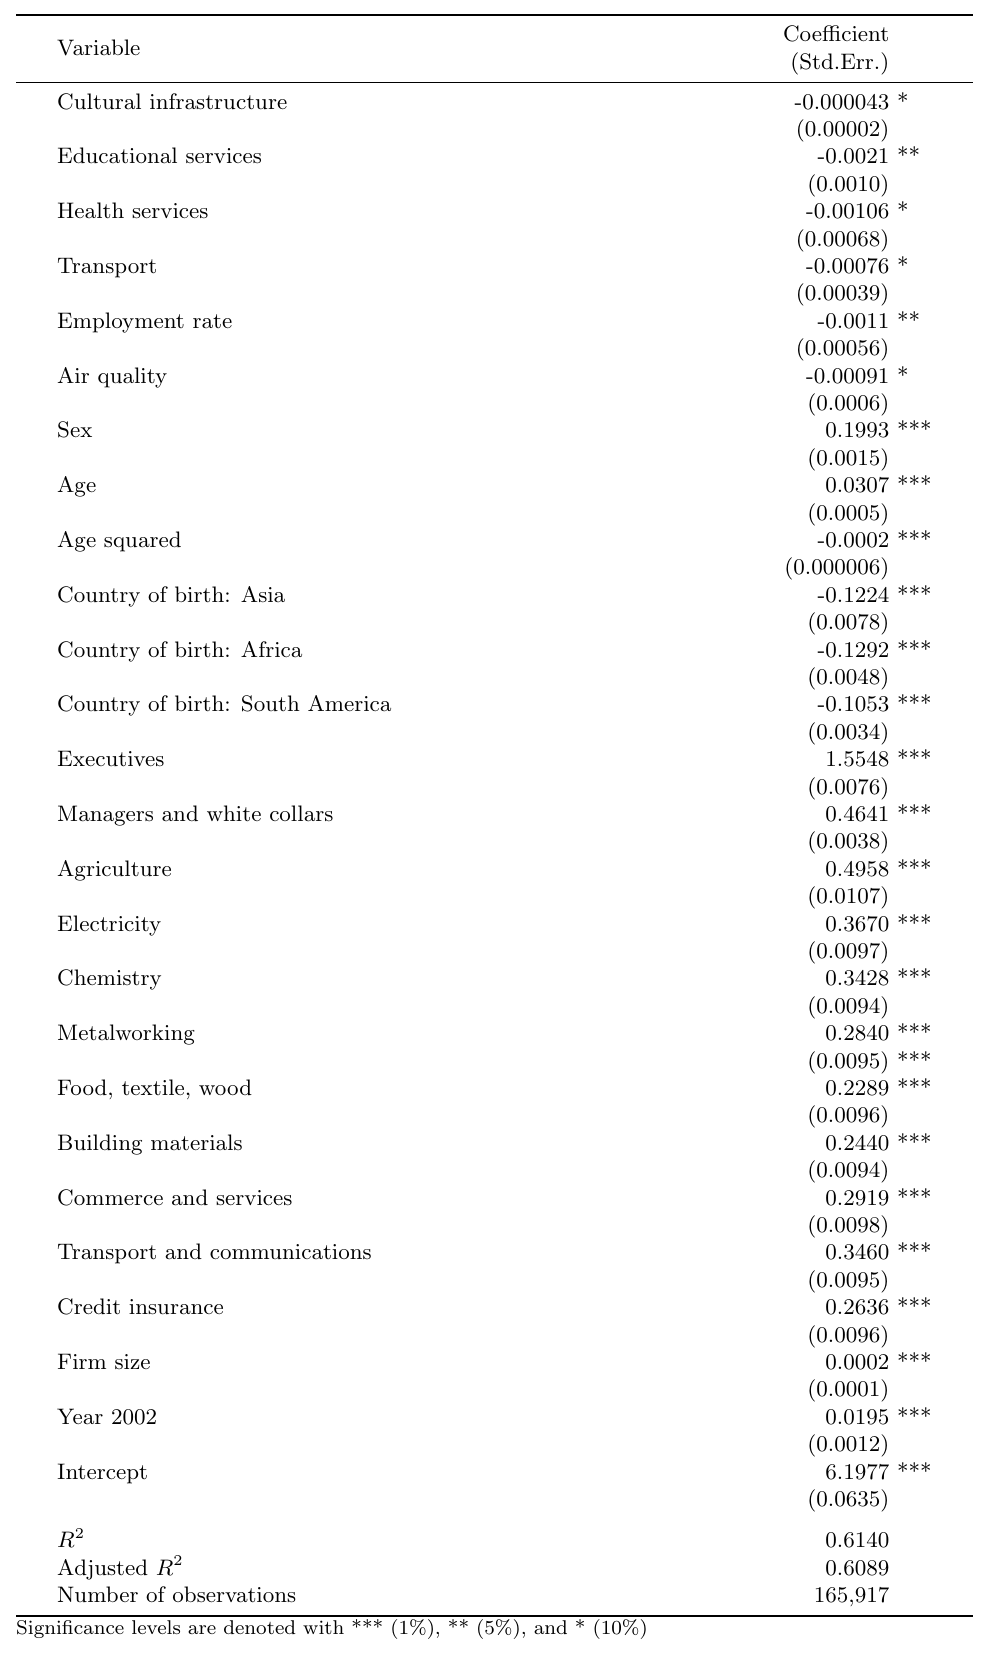
Table A.3: Estimation results for the wage